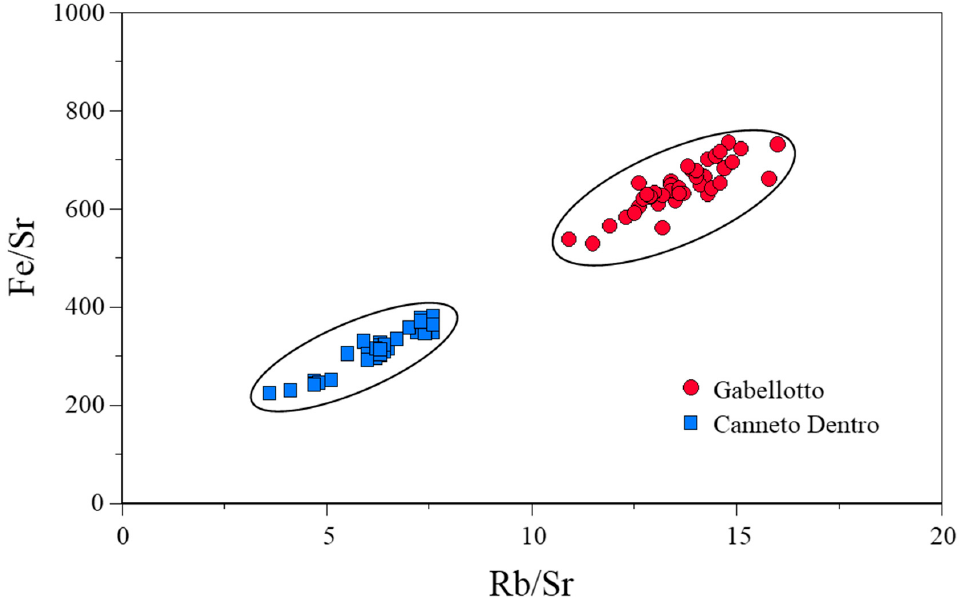
Figure 8. Two prehistoric Lipari obsidian groups used for tools, using geological samples collected by the author.